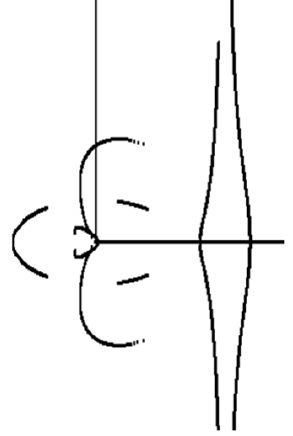
Figure 6. q = 1, KG = 50, and DK = 120.